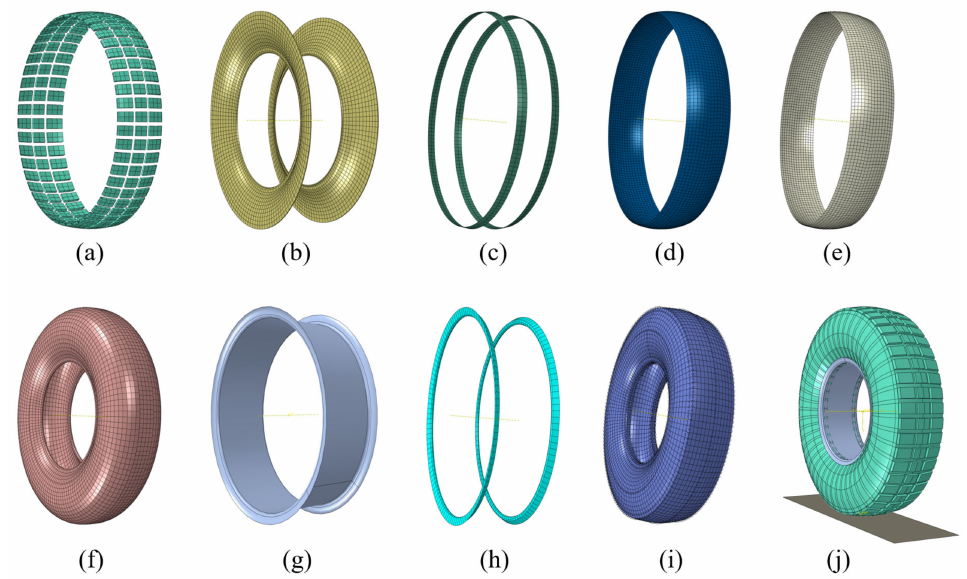
Figure 6. Components of the FE model: ( a ) tread; ( b ) sidewall; ( c ) steel-belt-1; ( d ) steel-belt-2; ( e ) steel-belt-3; ( f ) ply; ( g ) rim; ( h ) bead and apex; ( i ) carcass; ( j ) the tire–road contact model.